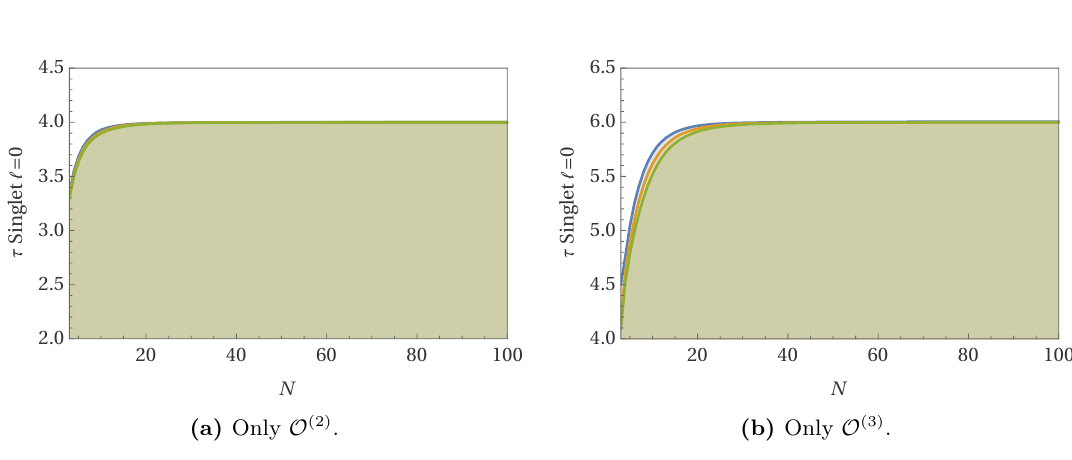
Figure 3. Upper bound for the gap on the twist of all singlets as a function of N . The different curves are the different values of Λ = 19 , 23 , 27 . Here we pushed to much higher N to show where it starts converging to τ = 4 . The left plot uses only hO (2) O (2) O (2) O (2) i while the right plot uses only hO (3) O (3) O (3) O (3) i (note the difference in the